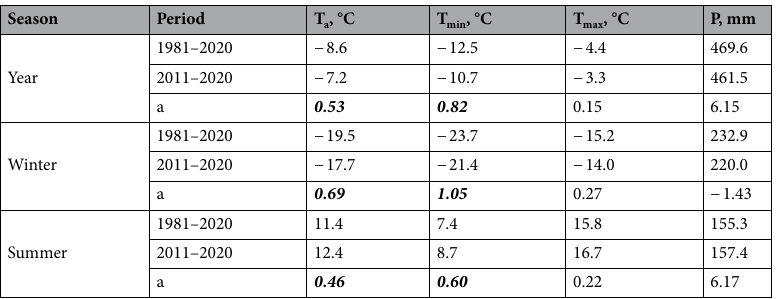
Table 1. Statistics of the mean annual, winter and summer air temperature and precipitation sums for Norilsk [T a , T min and T max designate averaged over the season daily mean, minimum and maximum air temperatures; a – linear trend coefficient for the period 1981–2020; °C/10 years for air temperature and mm/10 years for precipitation sums’ Bold italic designate trends significant at 95% level] [Russian Foundation for Basic Research, Project no